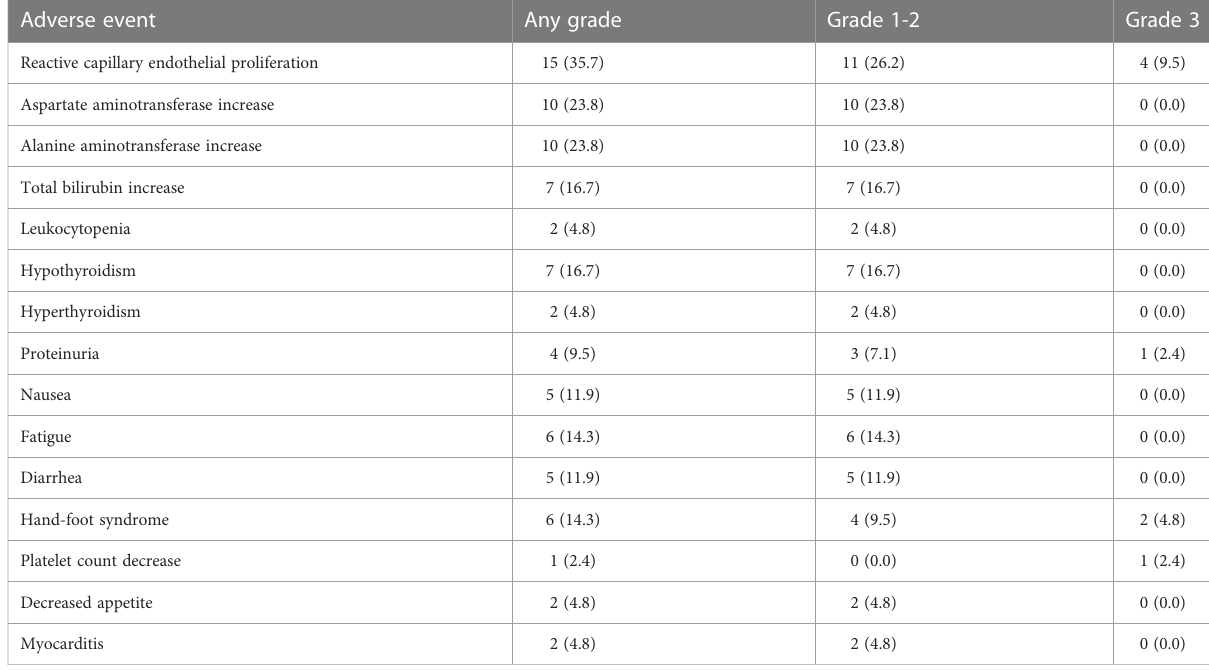
TABLE 3 Adverse Events Related to PD-1 Inhibitor Administration in the MTP Group. Adverse